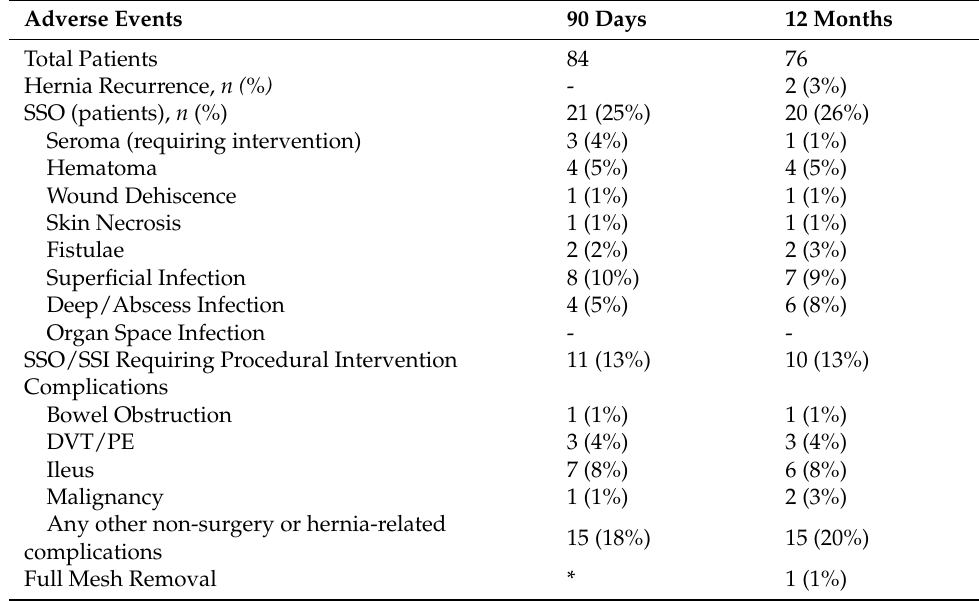
Table 3. Primary and Secondary Endpoints: Adverse Events.